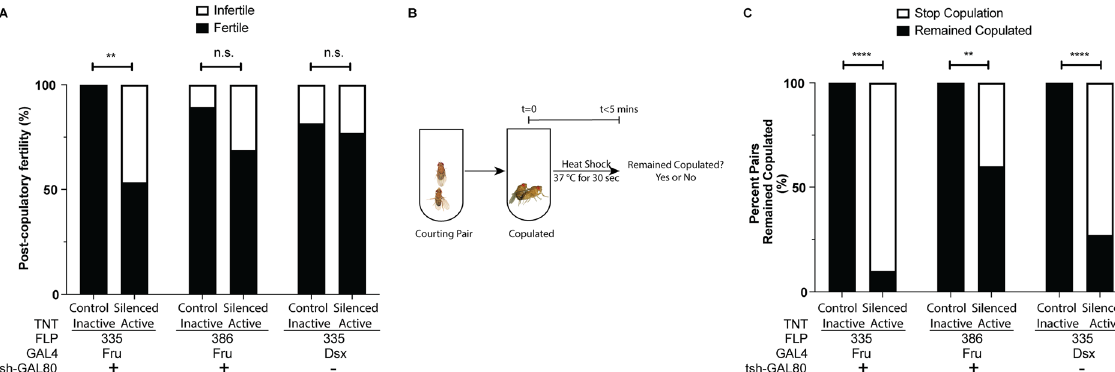
Figure 4. Sensory information detected by fru / dsx -MSNs is necessary to maintain copulation persistence. Mating pairs were set up between males expressing TNT in either FLP 335 or FLP 386 restricted dsx or fru